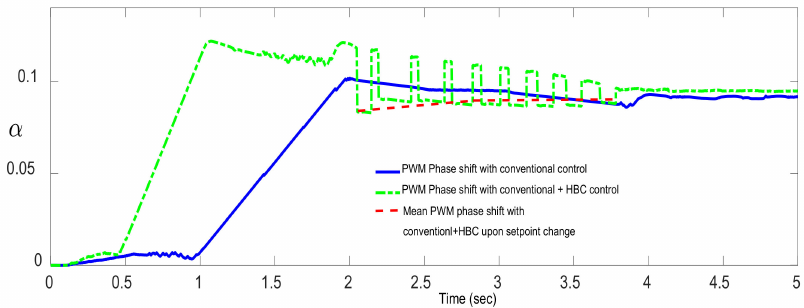
Figure 6. PWM phase shift during disturbance with conventional control vs. proposed control scheme.